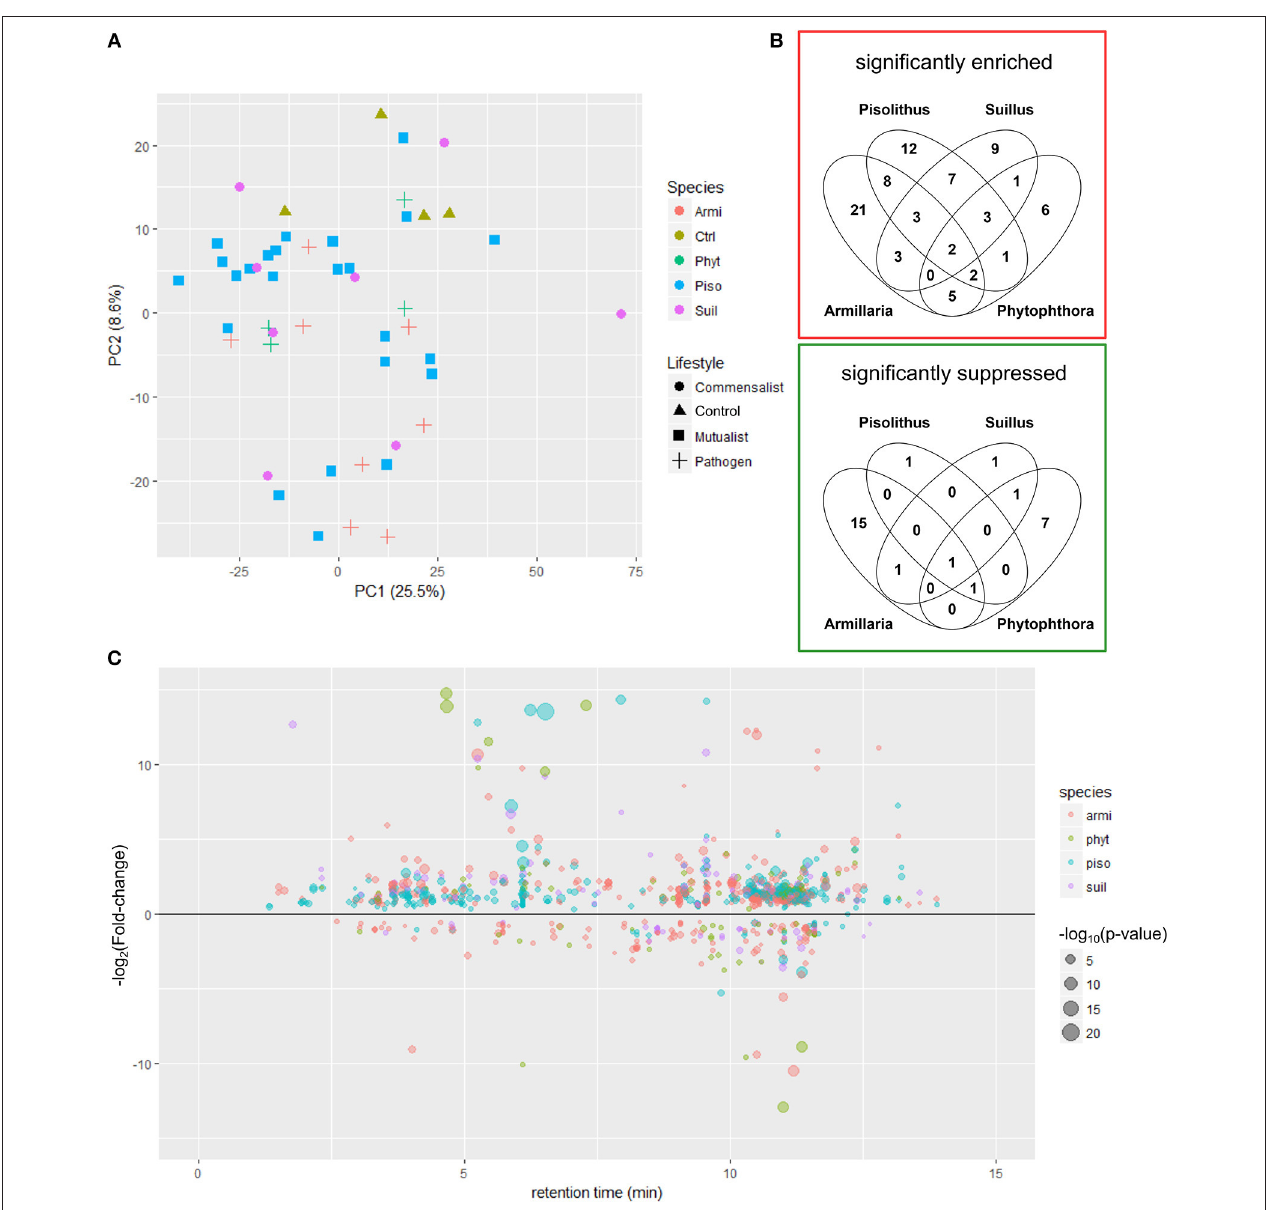
FIGURE 2 | Metabolite responses triggered by different lifestyles of interacting microbe (A) PCA score plot showing the variation among metabolite profiles (LC-MS ESI + mode) of E. grandis root tips after 24h pre-symbiosis with different microbes. The color and shape of symbols represent the species and the lifestyles of the interacting microbes. Armi, Armillaria luteobubalina ; piso, Pisolithus microcarpus ; suil, Suillus granulatus ; phyt, Phytophthora cinnamomi ; ctrl, uninfected control (B) venn diagrams showing the significantly enriched and suppressed molecular features amongst different microbe-treated roots in comparison to the untreated control. Student t -test was performed for each pair of comparison between the control and the microbes-treated root tips. Significantly regulated molecular features profiled with ESI + mode that exhibit more than 5-fold of intensity change and with p < 0.05 are shown in the Venn diagram. (C) The scatter plot showing distribution of the significantly regulated metabolites ( p < 0.05) across the span of retention time of metabolite profiling in root tips after pre-symbiotic interaction with microbes of different species that are captured in LC-MS (ES + mode).